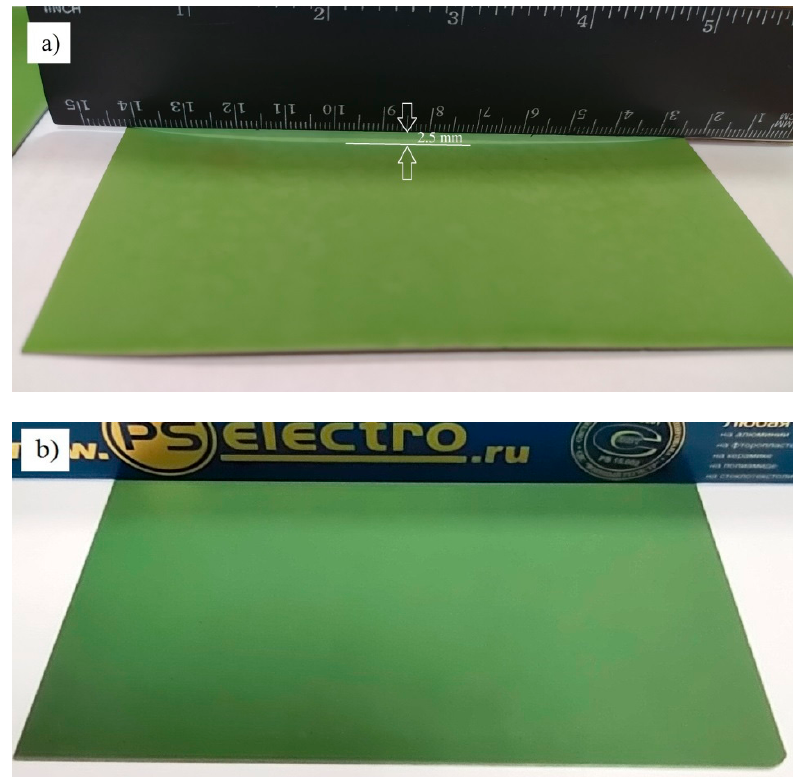
Figure 11. Photographs of ASCs with YSZ electrolyte film deposition: ( a ) in oxide mode followed by stress-free annealing; electrolyte on ASC underside, ( b ) in transition mode and annealed under load; electrolyte on ASC